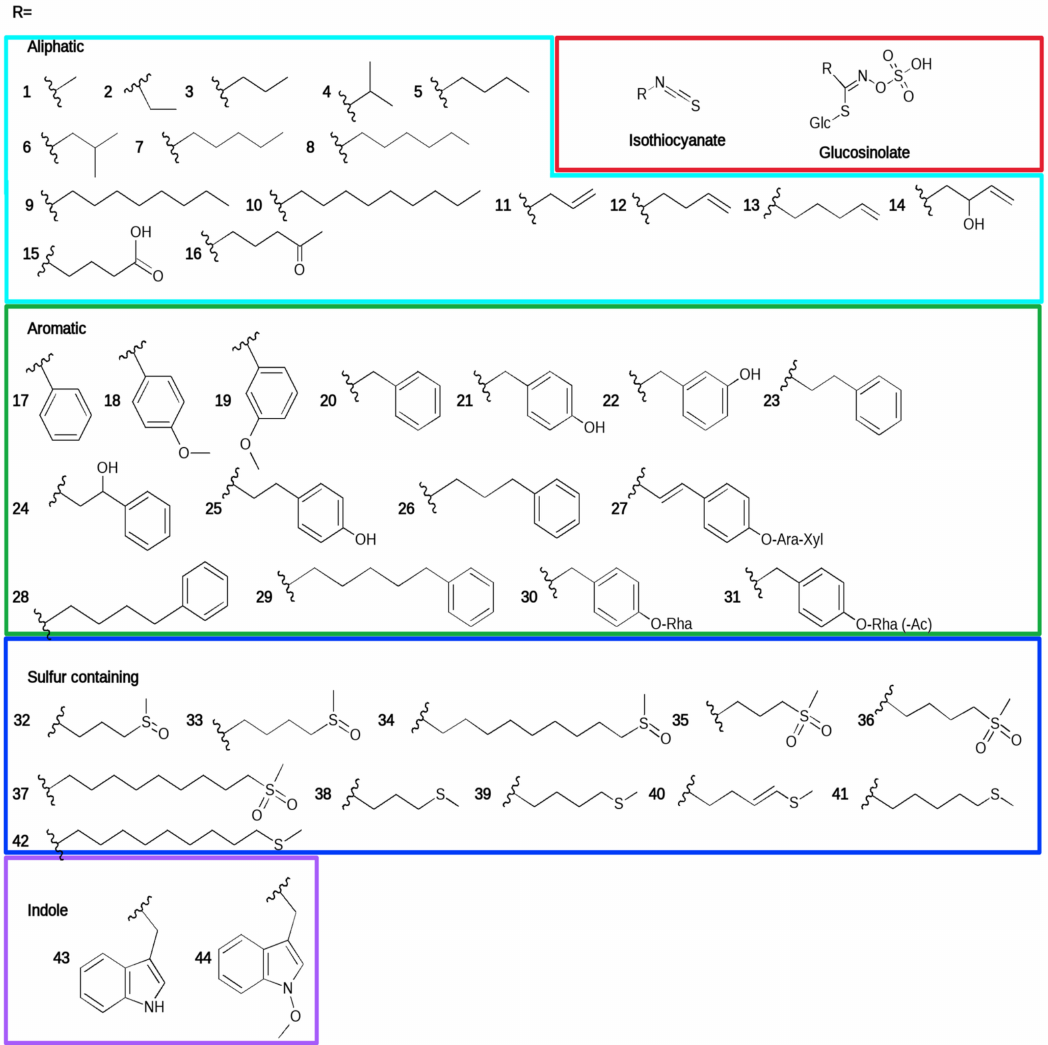
Figure 1. Glucosinolates and isothiocyanates mentioned in the current review. The classification is based on [5]. If available, the trivial names for glucosinolates are mentioned in the absence of trivial names, the GSL name is formed from the side chain name. Abbreviations: Ac—acetyl-group, Ara—arabinoside; Glc—glucoside; ITC—isothiocyanate;